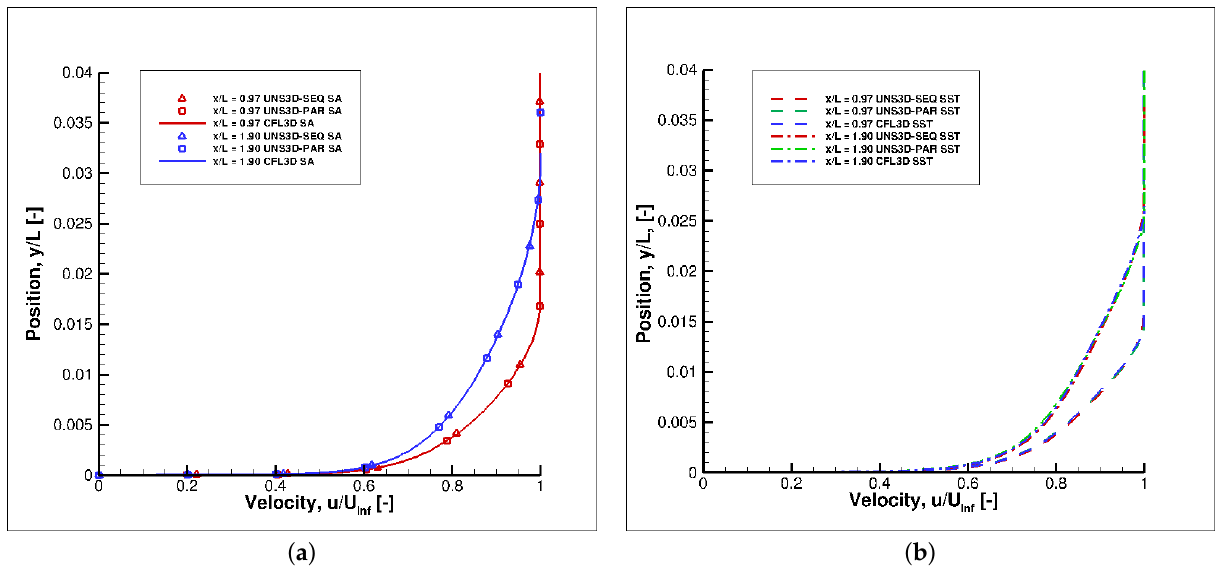
Figure 9. Velocity profiles on turbulent flat plate: ( a ) Spalart–Allmaras, and ( b ) Shear Stress